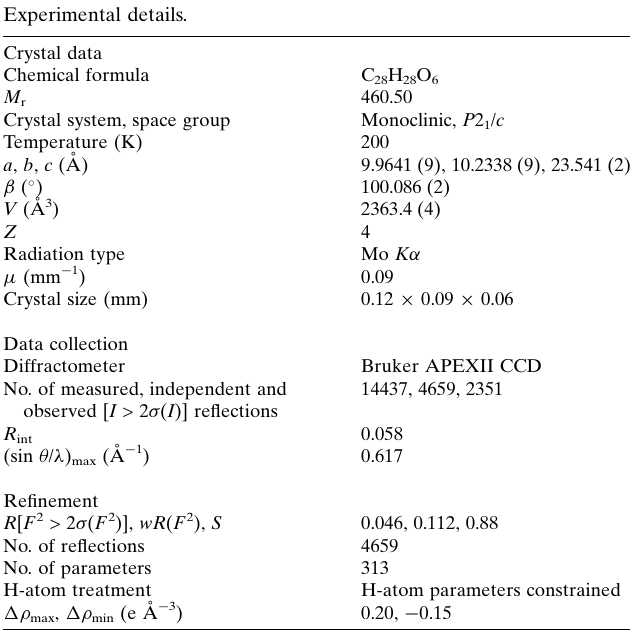
Table 2 Experimental